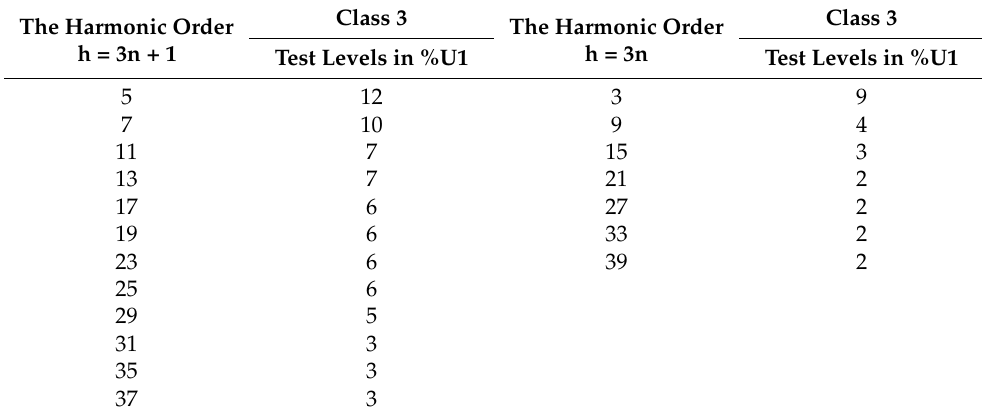
Table 3. The magnitude of particular harmonics of the supply voltage used in low-frequency